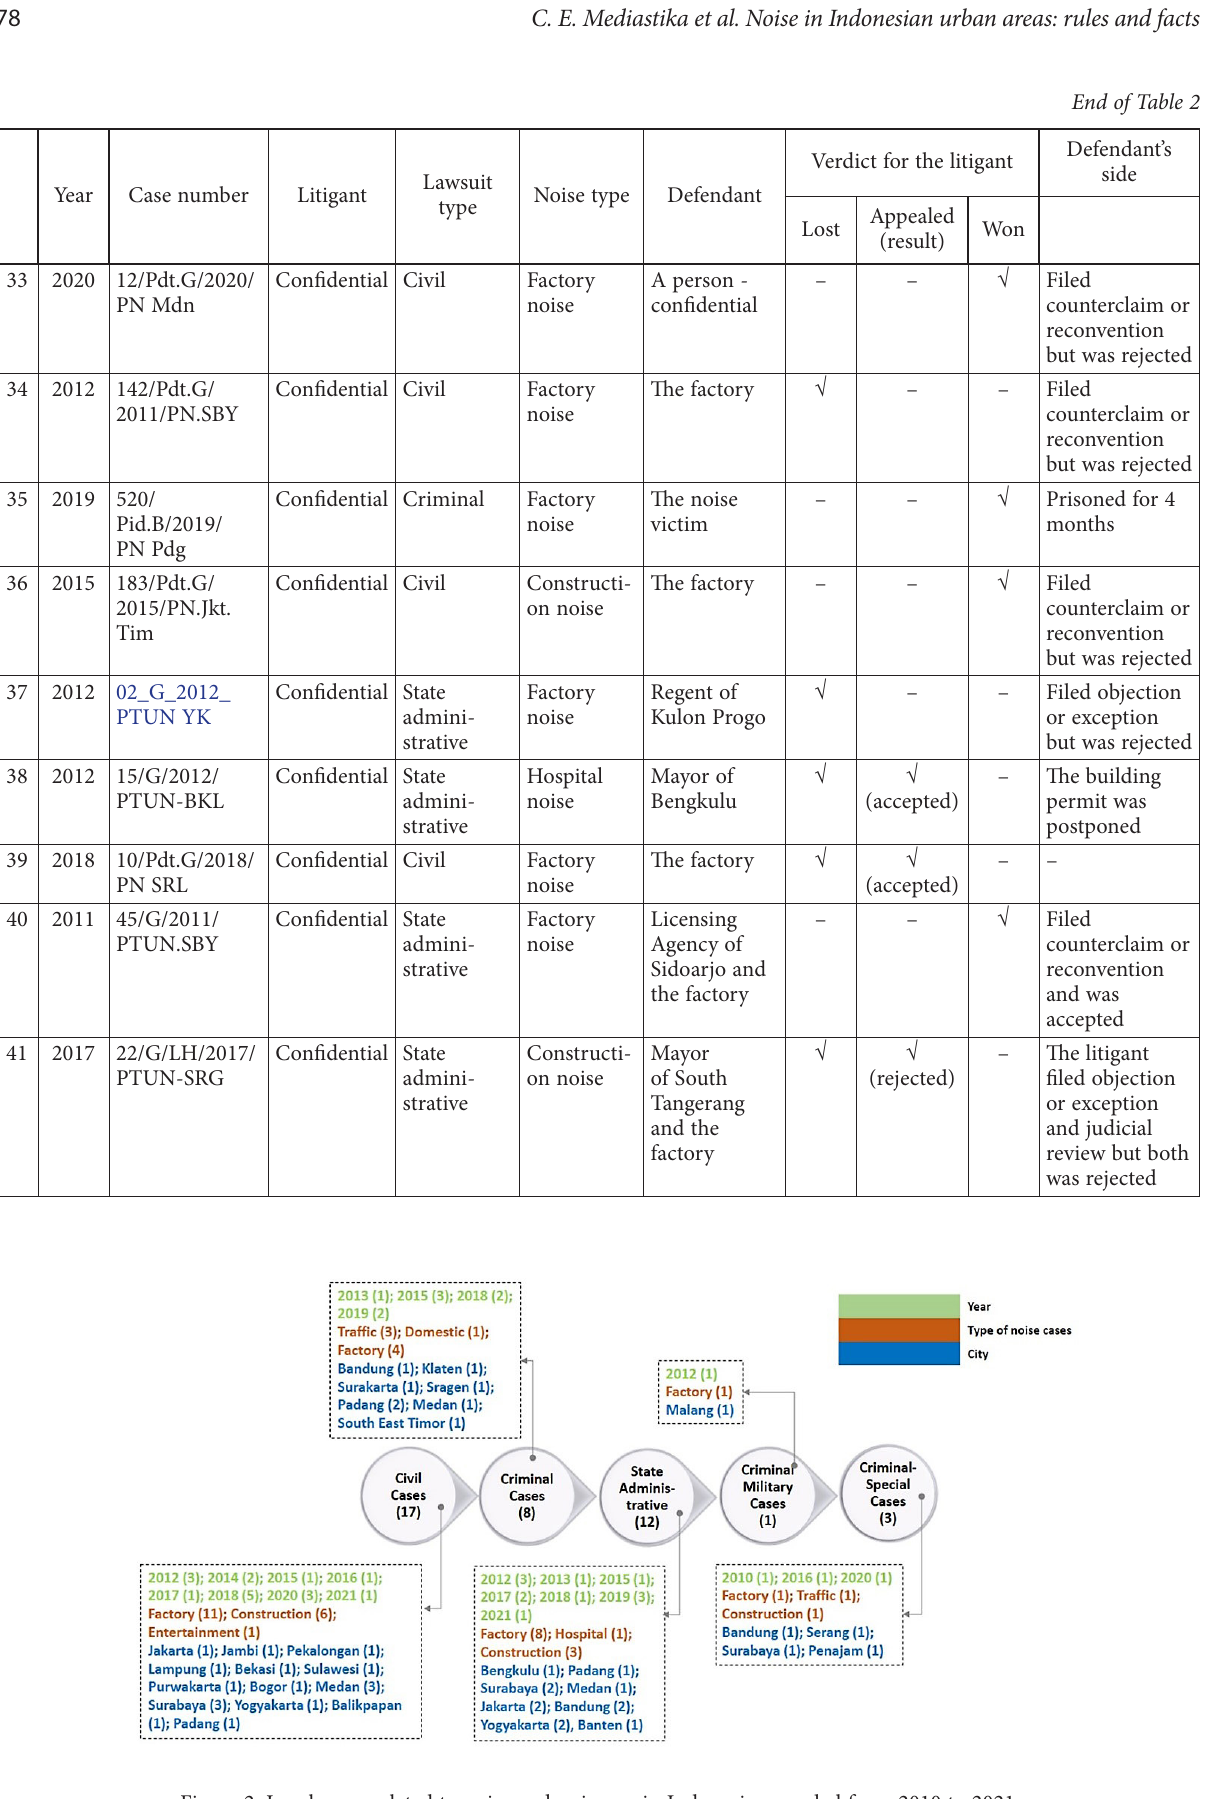
Figure 2. Legal cases related to noise and nuisance in Indonesia recorded from 2010 to